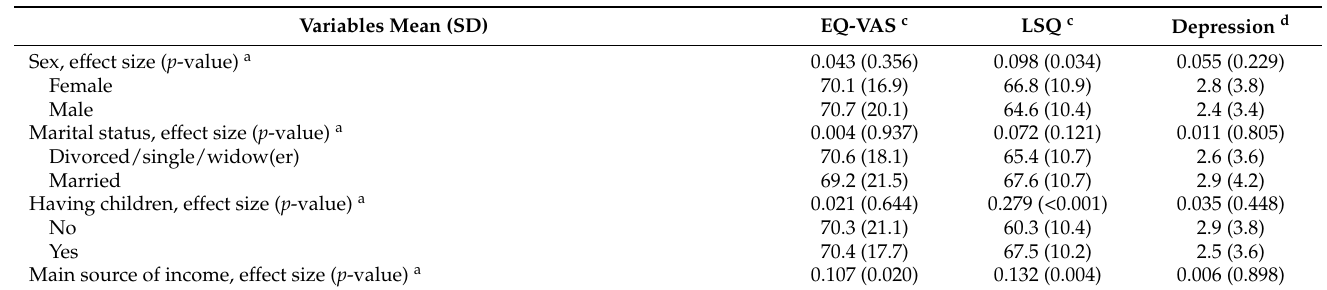
Table 2. Well-being compared for different subgroups ( n =